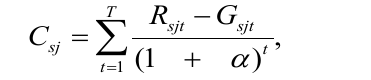
Table 1. Factors of influence on the rank of a stakeholder and methods of their assessment